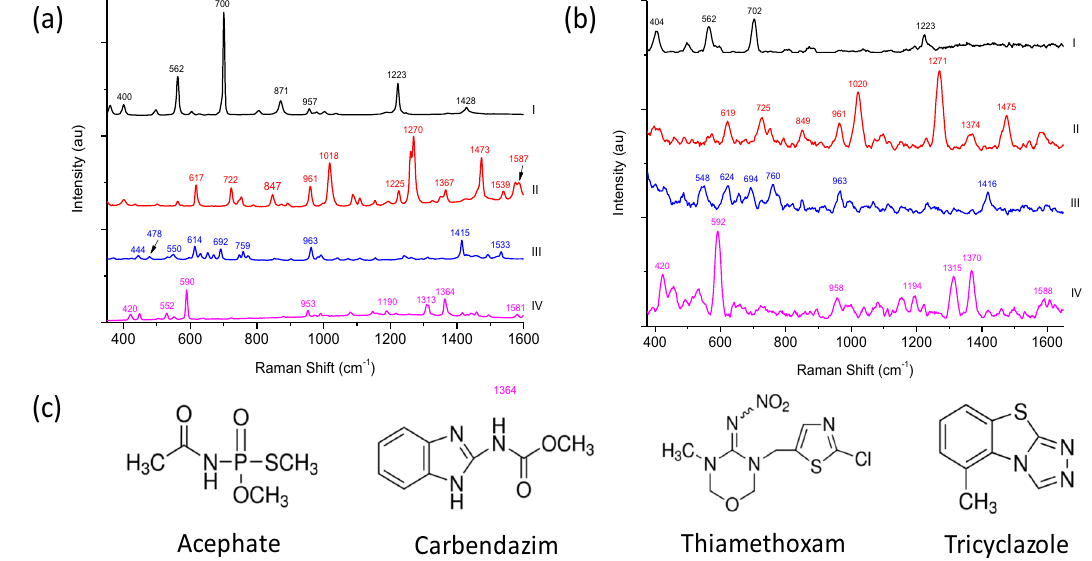
Fig. 1 Raman scattering and molecular structures of pesticide residues. Raman ‘ fi ngerprint ’ spectra of (I) acephate (II) carbendazim (III) thiamethoxam and (IV) tricyclazole powder, obtained using ( a ) benchtop Raman microscope and ( b ) handheld Raman spectrometer (spectra is pre-treated using an advanced-averaging fi lter). (c) Molecular structures of